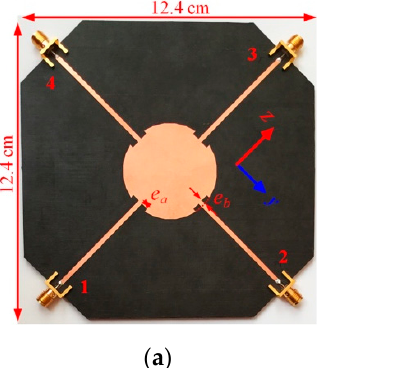
( b ) Figure 9. Simulated insertion loss between the ports of two-port antenna for various: ( a ) angle; and ( b ) height of the truncated triangular-shaped ground plane. As discussed above, the connection between the ports’ ground plays an important role in improving the insertion loss between them. The important factor R d , which controls the dimension of the connected part, and corresponding isolation between the ports, is swept around its optimum value R d = 36 mm, as shown in Figure 10. This results in increasing R d , and hence decreases the thickness of the connected section and causes the S 21 curve to shift to lower frequencies. Figure 10. Effect of the inner radius of the ground plane sector on simulated insertion loss.